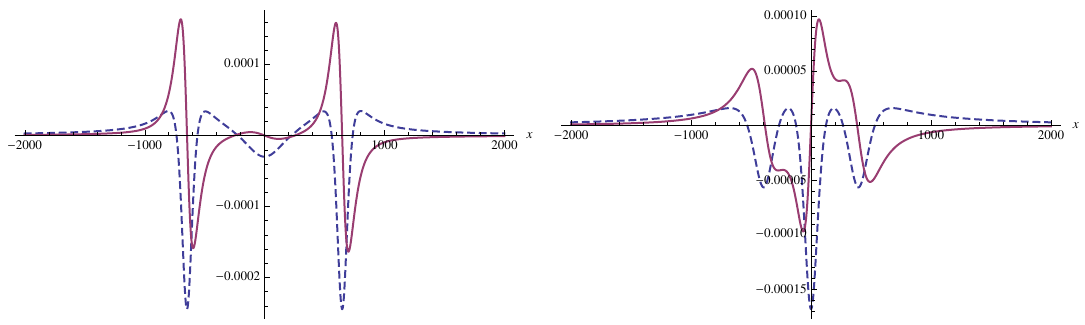
Figure 4 . Real (shown by dashed lines) and imaginary (shown by continuous lines) parts of -symmetric stationary solution to eq. (2.31) at α = 300 potential (2.39), (2.41) as a complex PT and ν = 60 (on the left) and ν = 5 (on the − −